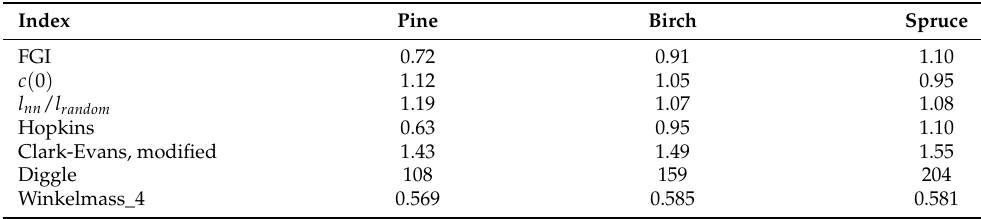
Table 4. Distribution indices in RAMI stands.